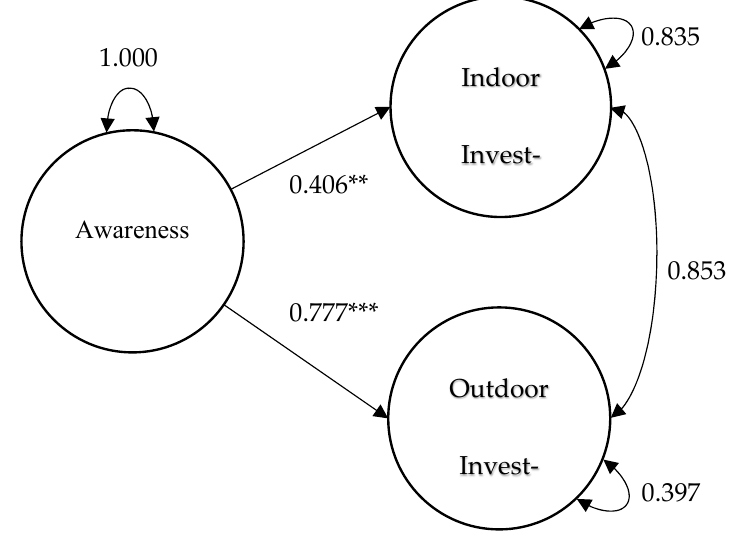
Figure 4. Model of owning water-saving appliances for indoor and outdoor usage regressed on awareness of water supplies for well owners ( n = 407).